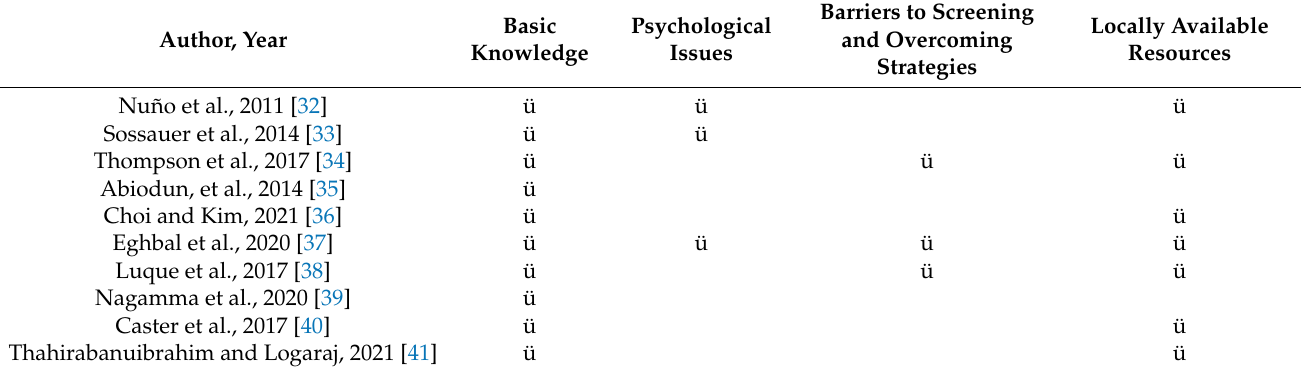
Table 5. Educational